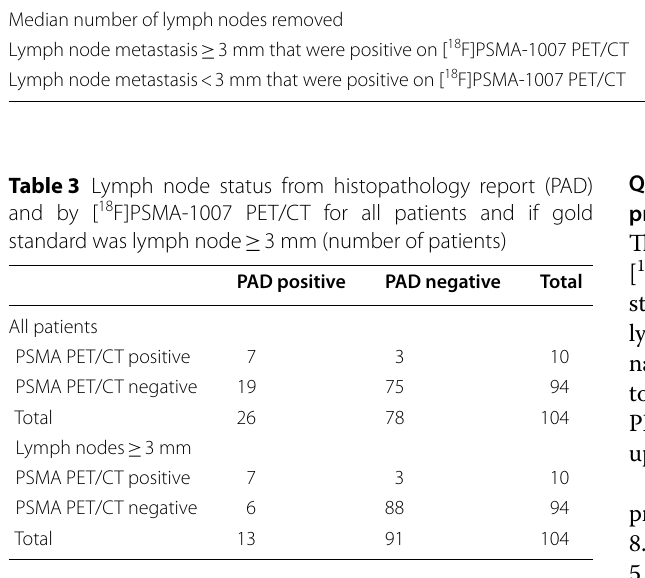
Table 2 Histopathology reported lymph nodes removed at ePLND Total number of lymph nodes removed from 104 patients n Total number of lymph nodes with histologically confirmed metastasis (%)